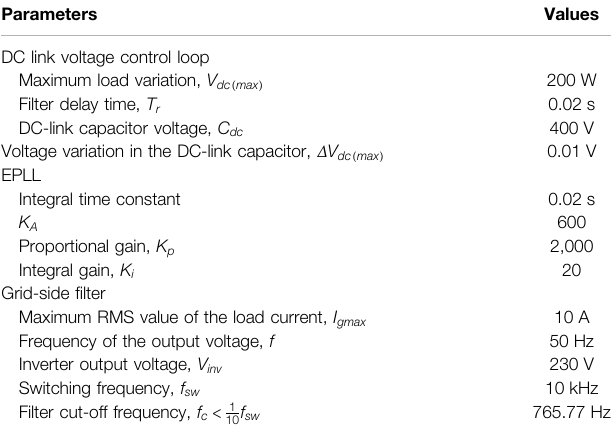
TABLE 2 | Parameters for DC bus voltage controller for ES. Parameters